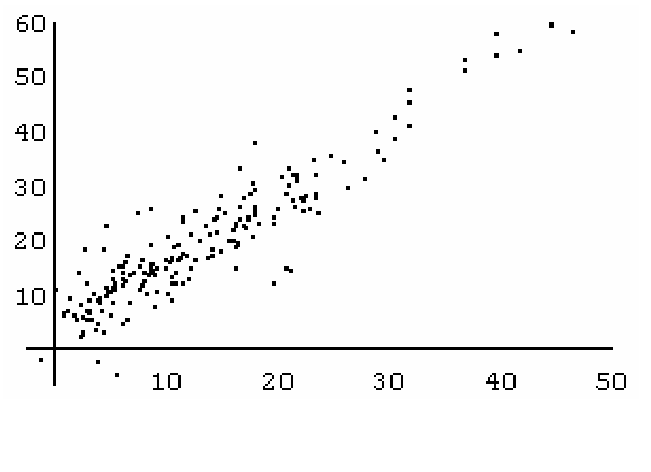
Figure 1 . DCW 1 (vertical axis) versus DCW 0 (horizontal axis). Regression equation: DCW 1 = 2.978 + 1.222 DCW 0